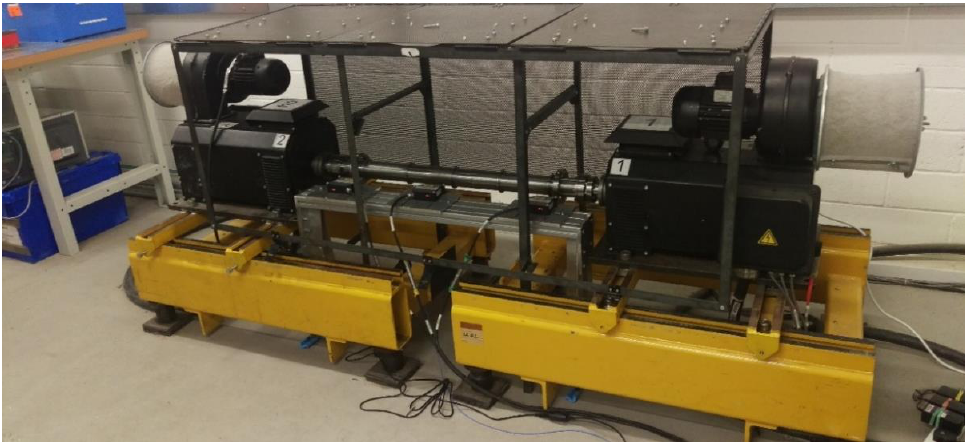
Figure 1. High speed test facility.